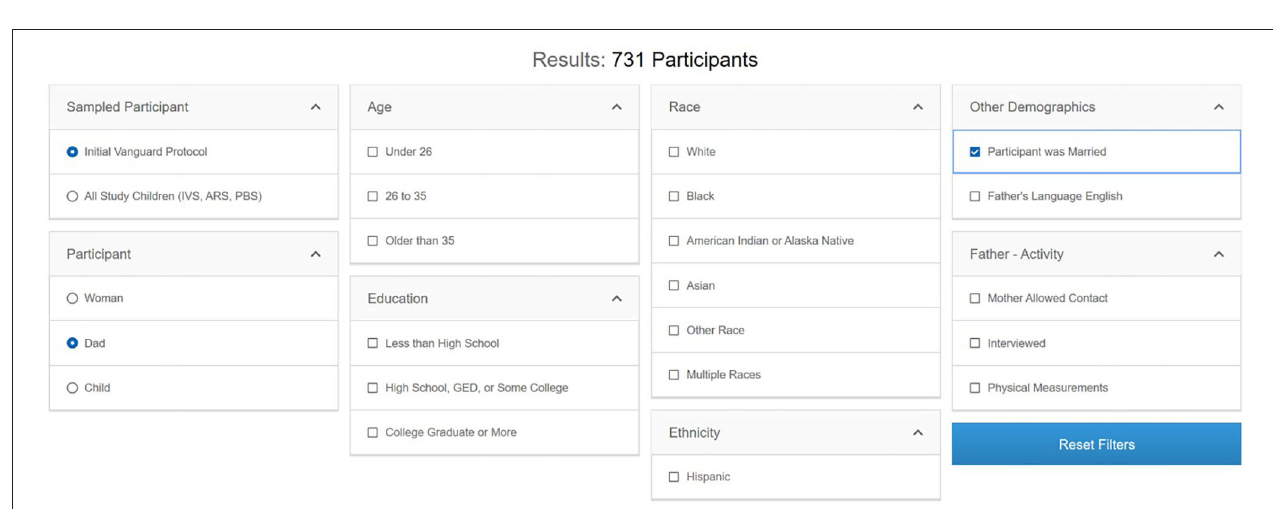
FIGURE 7 | Participant Explorer for father participants in the IVS